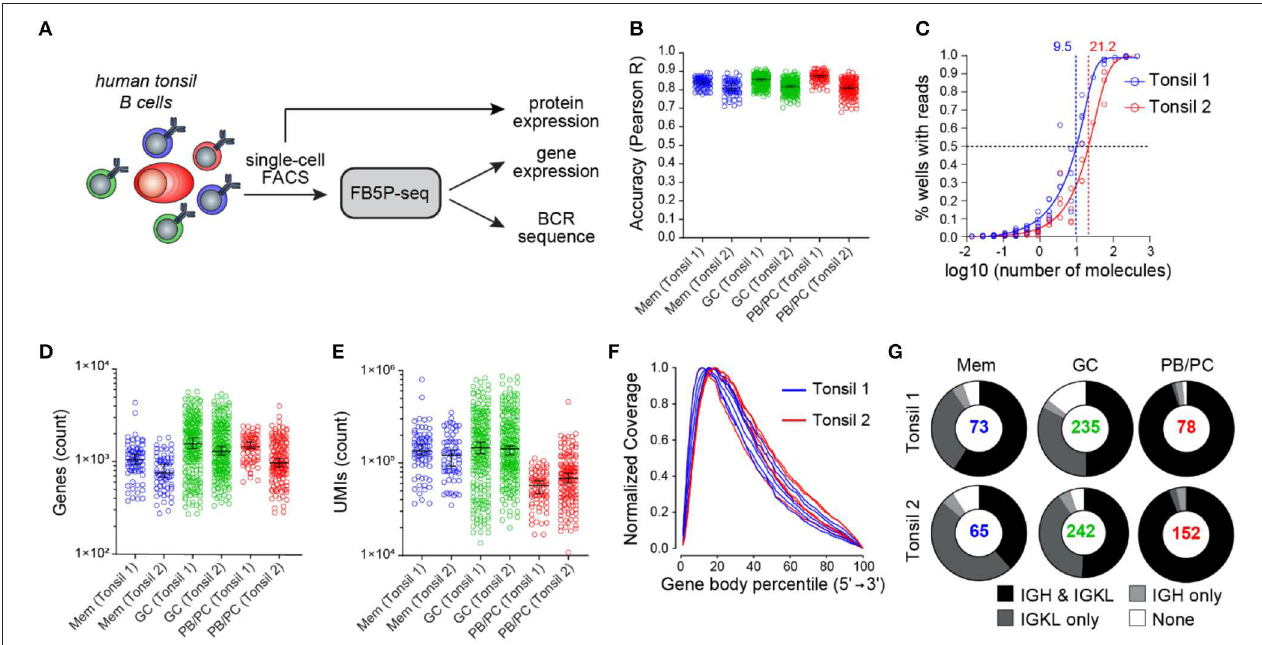
FIGURE 3 | FB5P-seq quality metrics on human tonsil B cell subsets. (A) Experimental workflow for studying the human tonsil B cell subsets with FB5P-seq. (B) Per-cell quantitative accuracy of FB5P-seq computed based on ERCC spike-in mRNA detection (see section Materials and Methods) for memory B cells (Mem, n = 73 tonsil 1, n = 65 tonsil 2), GC B cells (GC, n = 235 tonsil 1, n = 242 tonsil 2), and PB/PCs ( n = 78 tonsil 1, n = 152 tonsil 2). The black line indicates the median with 95% confidence interval error bars. (C) Molecular sensitivity of FB5P-seq computed on ERCC spike-in mRNA detection rates (see section Materials and Methods) in two distinct experiments. The dashed lines indicate the number of ERCC molecules required to reach a 50% detection probability. (D,E) Total number of unique genes (D) and molecules (E) detected in human tonsil Mem B cells ( n = 73 tonsil 1, n = 65 tonsil 2), GC B cells ( n = 235 tonsil 1, n = 242 tonsil 2), and PB/PCs ( n = 78 tonsil 1, n = 152 tonsil 2). The black line indicates the median with 95% confidence interval error bars. (F) Gene body coverage analysis for tonsil 1 ( n = 5) and tonsil 2 ( n = 6) plate libraries. Each curve was computed from the BAM file corresponding to one library from a 96-well plate pool (see section Materials